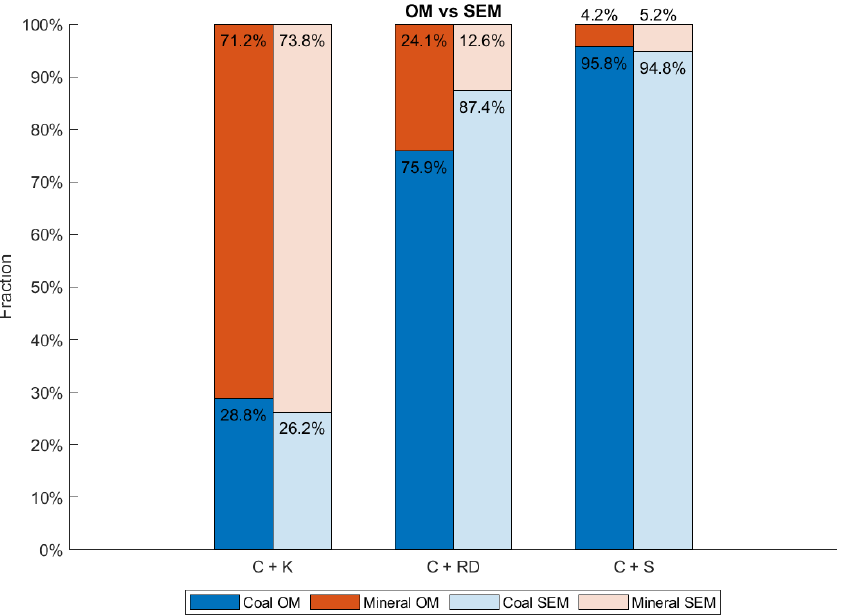
Figure 8. Coal and mineral fractions in composite samples containing coal and one mineral based on OM and SEM-EDX classification. The particle size data derived from the OM and SEM-EDX analyses were also used to construct cumulative particle size distributions (CPSDs) for each dust sample based on